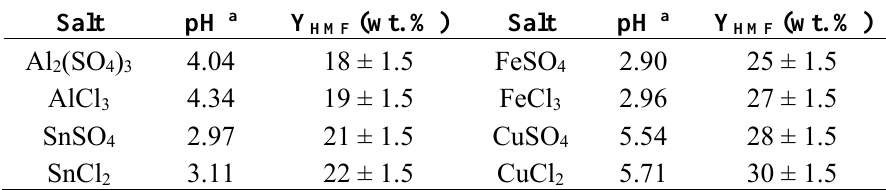
Table 2. pH of the solutions of the metal salts in water.